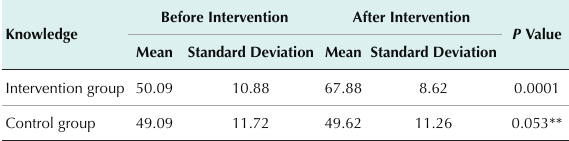
Results from paired t -test and Wilcoxon test.